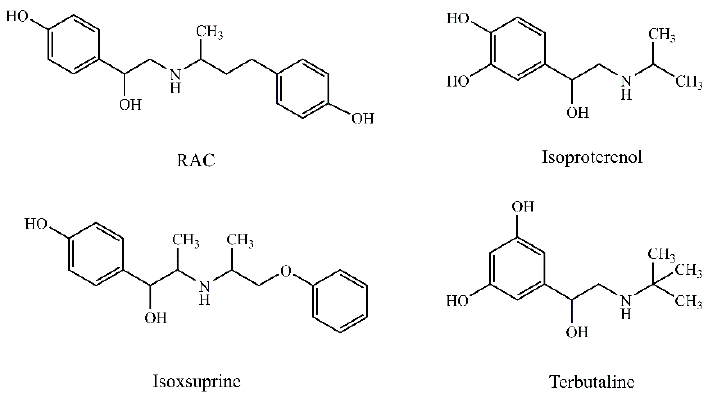
Figure 1. Chemical structure of RAC, isoproterenol, terbutaline and isoxsuprine.